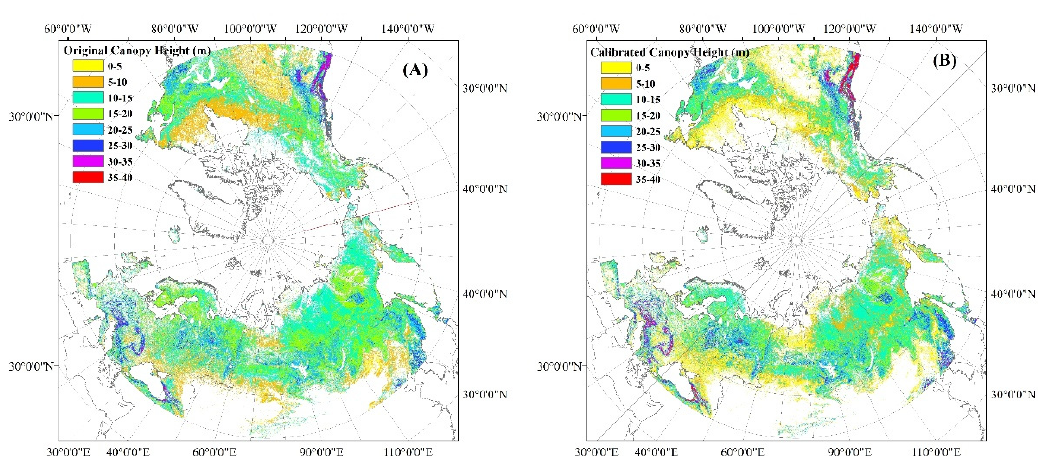
Figure 3. Spatial distributions of the original (A) and calibrated (B) Simard-map of canopy height in boreal forests.